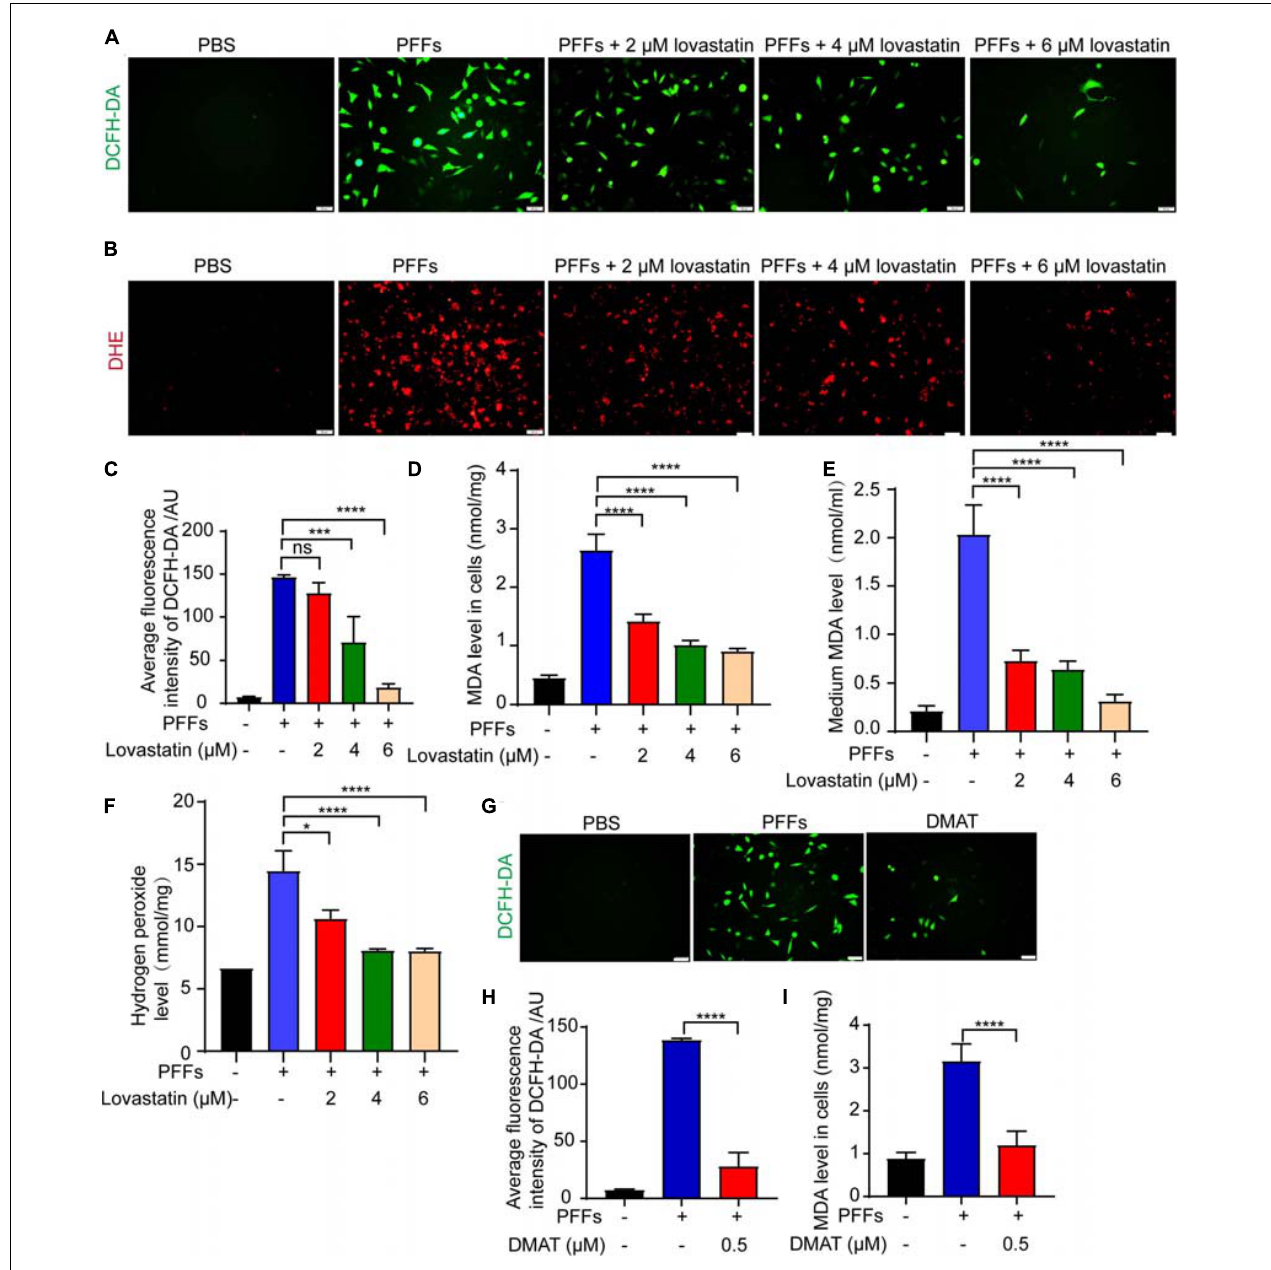
FIGURE 5 | Lovastatin mitigates oxidative stress induced by PFFs. (A,B) ROS was detected after lovastatin treatment by DCFH-DA probe (A) and DHE probe (B) . Bar = 50 µ m. (C) Quantification of the DCFH-DA florescence. (D) Quantification of MDA after lovastatin treatment in the SH-SY5Y cells. (E) Quantification of MDA after lovastatin treatment in the medium. (F) Quantification of hydrogen peroxide in the SH-SY5Y cells. (G) ROS was detected after DMAT treatment by DCFH-DA probe. Bar = 50 µ m. (H) Quantification of DCFH-DA florescence after DMAT treatment. (I) Quantification of cellular MDA after DMAT treatment. All data are means ± SEM, * P < 0.05, and **** P < 0.001, ns: not statistically significant, one-way ANOVA with Tukey’s multiple comparisons test. All experiments were performed in triplicate for at least three independent